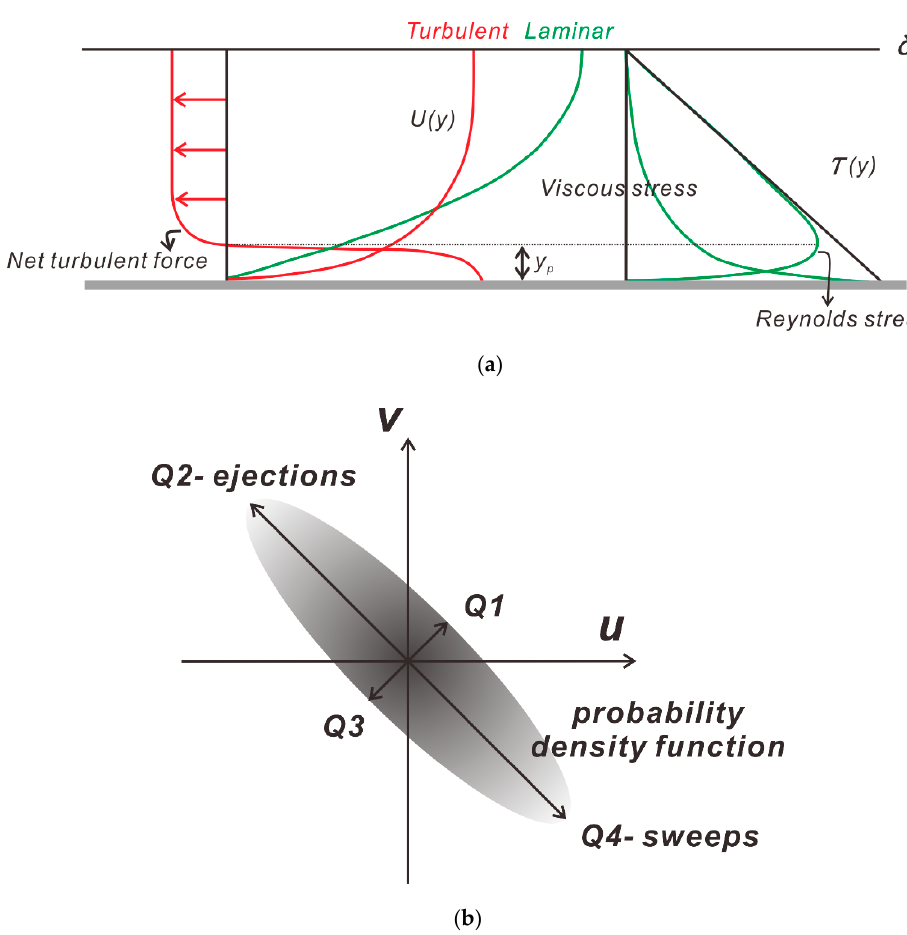
Figure 9. Profiles of shear stresses and net force due to Reynolds shear stress − ρ u (cid:48) v (cid:48) in fully developed channel flow ( a ) Profiles of shear stresses and net force ( b ) The trajectory in u–v plane traced by the velocity vector constituting a large eddy (reproduced from [24]).